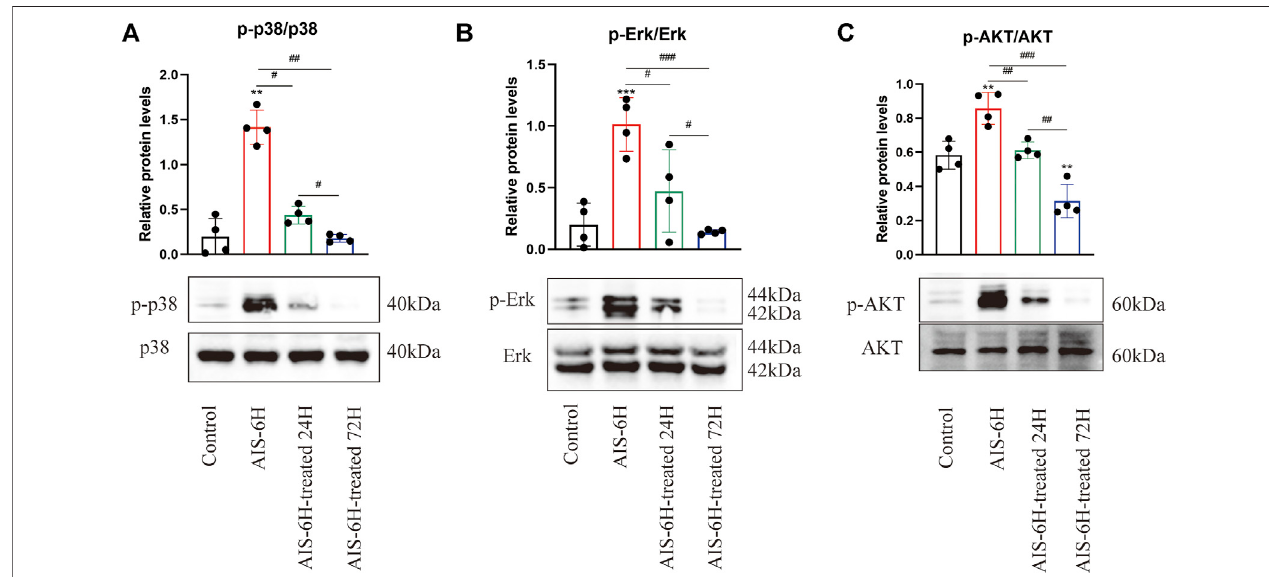
FIGURE 4 | AIS promoted phosphorylation of p38 MAPK, Erk1/2, and PI3K/Akt in serum. (A – C) Phosphorylation levels of p38 MAPK, Erk1/2, and PI3K/Akt in serum were detected by Western blotting; n (cid:2) 4. Data are presented as mean ± SD. Difference to control: ** p < 0.01; *** p < 0.001; # Difference between groups: # p < 0.05; ## p < 0.01; ### p < 0.001; and one-way ANOVA with the Newman – Keuls multiple comparison